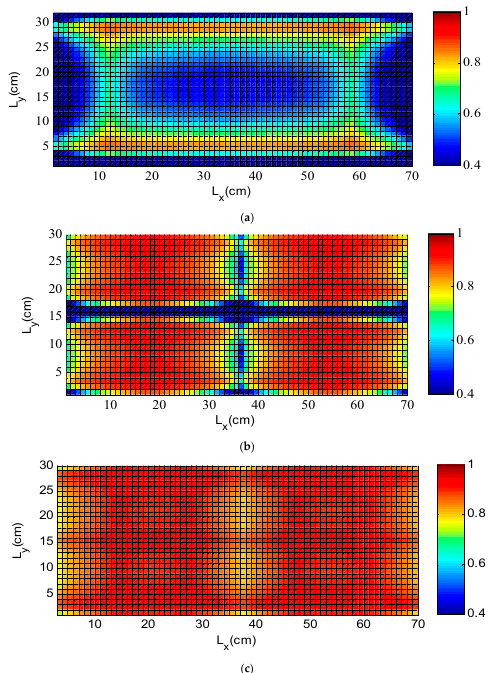
Figure 11. Calculated efficiency on the charging area for one primary coil ( a ), four primary coils without overlapping ( b ) and four primary coils with overlapping ( c ).